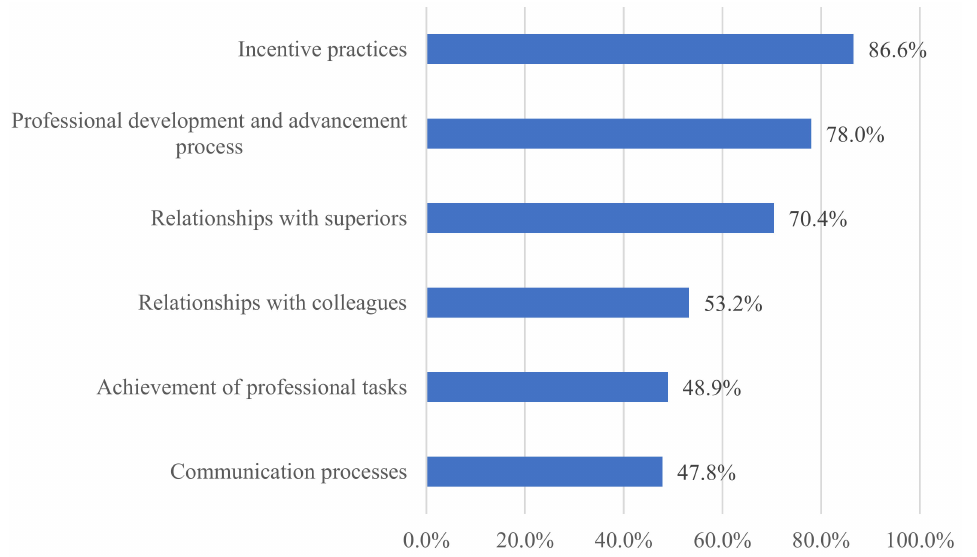
Figure 3. Organizational factors of commitment to innovation in SMEs. Source: Own